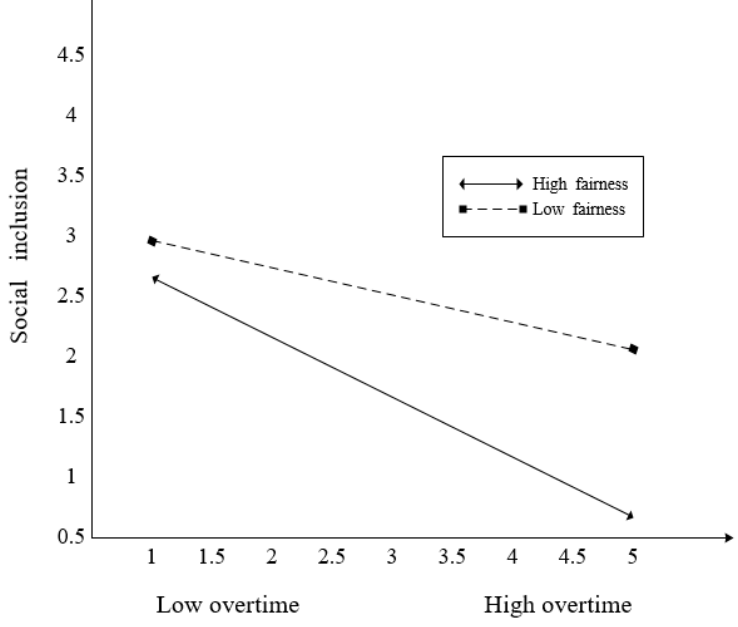
Figure 5. The moderating effect of fairness between overtime and social inclusion.